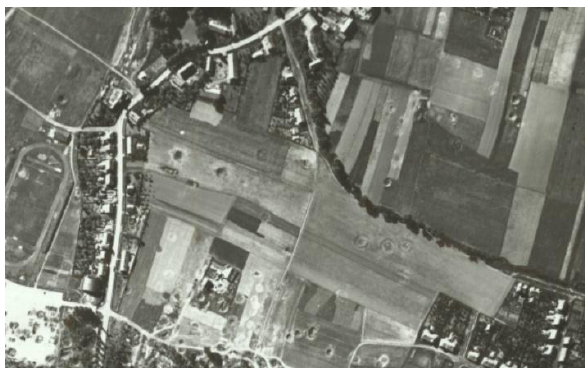
Figure 14 Identification of unexploded ammunition in an image of